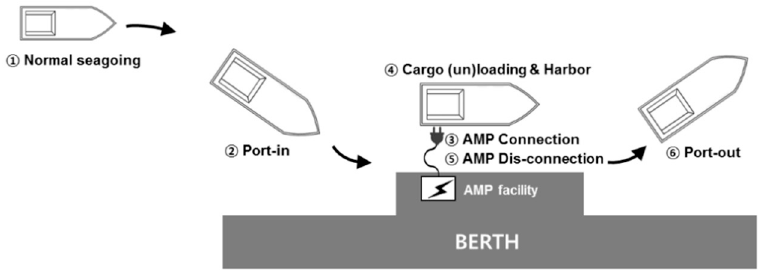
Figure 5. Docking / undocking procedure of a ship in the proposed system. Figure 5. Docking/undocking procedure of a ship in the proposed system.